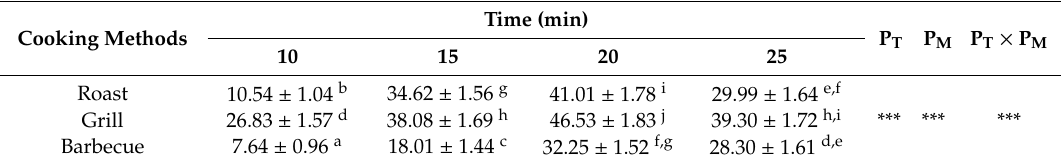
Table 1. The lipid radical content ( × 10 15 spin / g) in roasted, grilled, and barbecued beef over time at 200 ◦